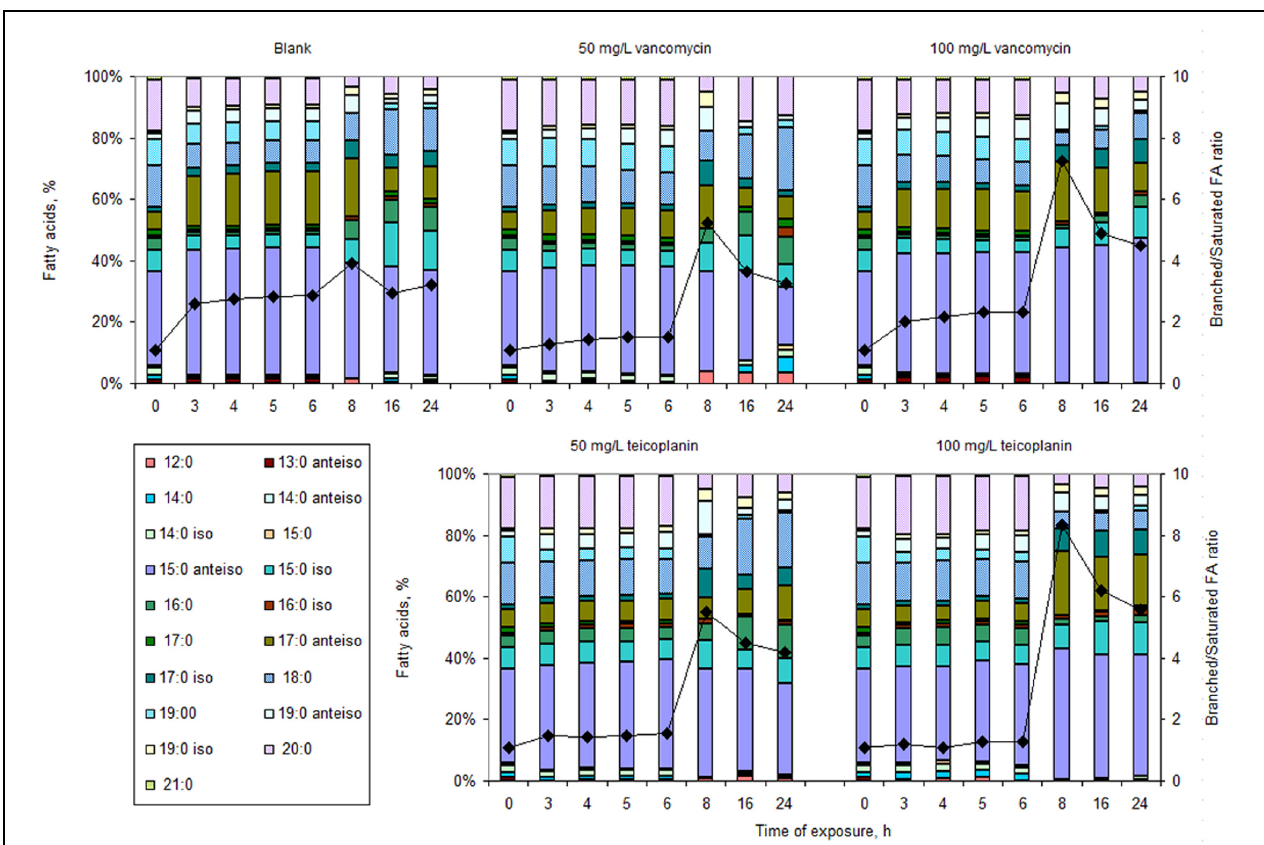
FIGURE 3 | Fatty acid (FA) composition of cells (bars) and corresponding branched/saturated FA ratio (diamonds) growing in MHB in the absence (Blank) or presence of 50 and 100 mg/L vancomycin and teicoplanin for 3, 4, 5, 6, 8, 16, and 24 h.